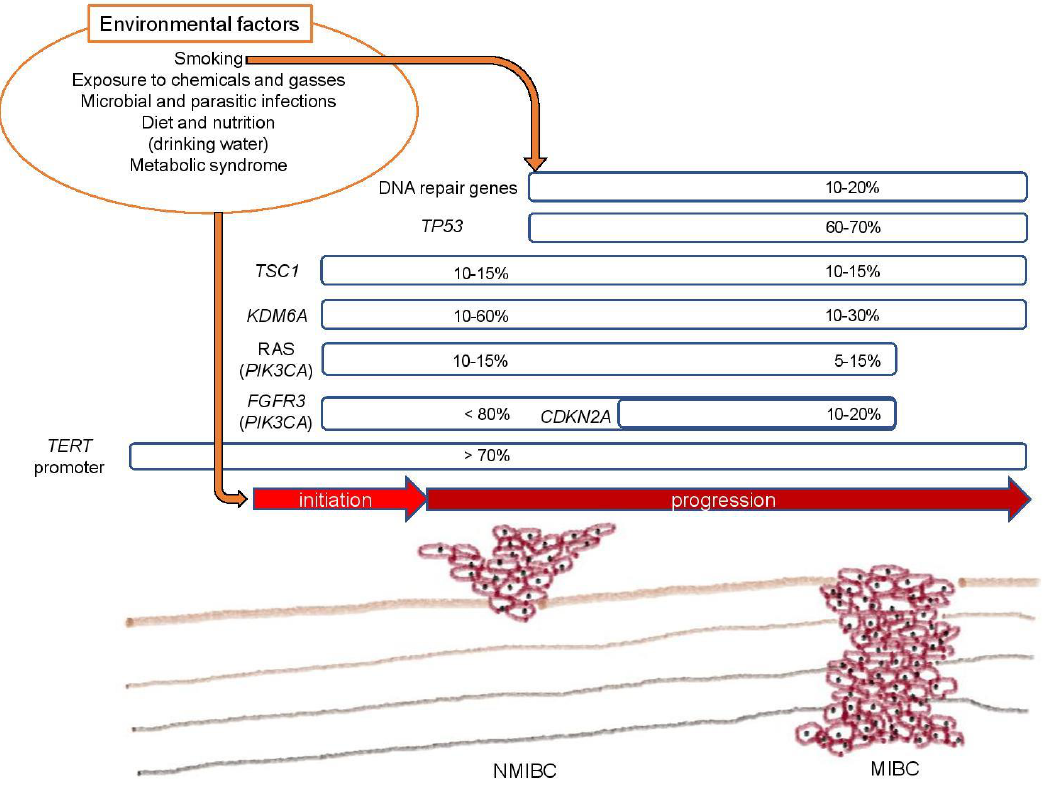
Figure 1. An overview of mutational landscape and environmental effects in bladder cancer. NMIBC, nonmuscle-invasive bladder cancer; MIBC, muscle-invasive bladder cancer.